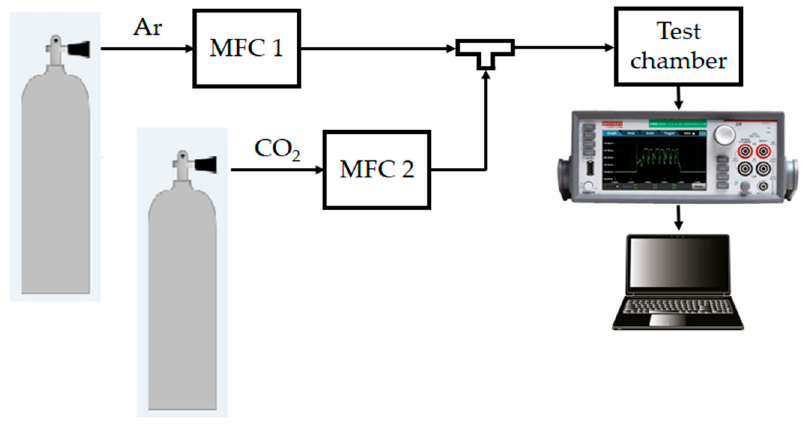
Figure 1. Schematic of the experimental setup. MFC 1 and 2 are mass flow controllers.